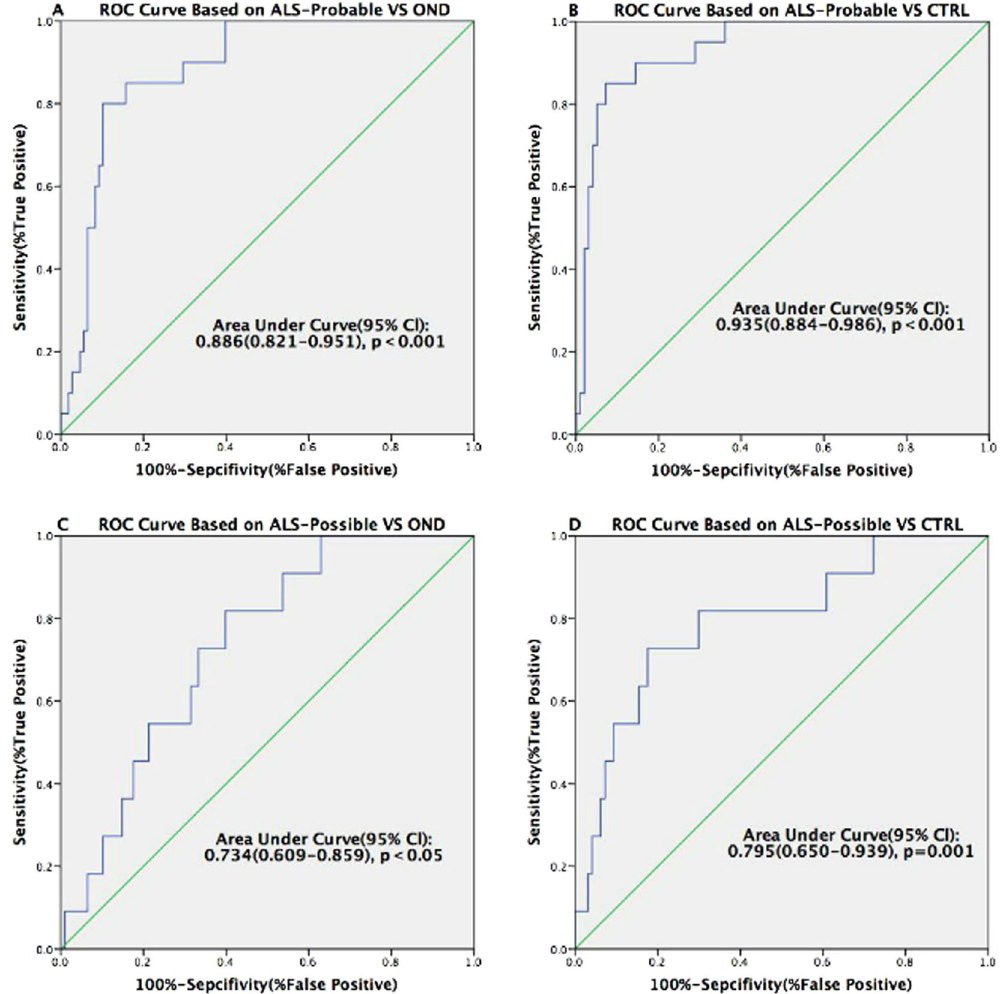
Figure 3. Receiver Operating Characteristic curves for distinguishing ALS-Probable/Possible patients from OND and CTRL. ( A ) The p75 ECD cut-off value was 6.6945 (ng p75 ECD /mg creatinine) between ALS-probable patients and OND; ( B ) The p75 ECD cut off value was 5.4301 (ng p75 ECD /mg creatinine) between ALS-probable patients and CTRL. ( C ) The p75 ECD cut-off value was 2.7201 (ng p75 ECD /mg creatinine) between ALS-possible patients and OND; ( D ) The p75 ECD cut-off value was 3.4685 (ng p75 ECD /mg creatinine) between ALS-possible patients and